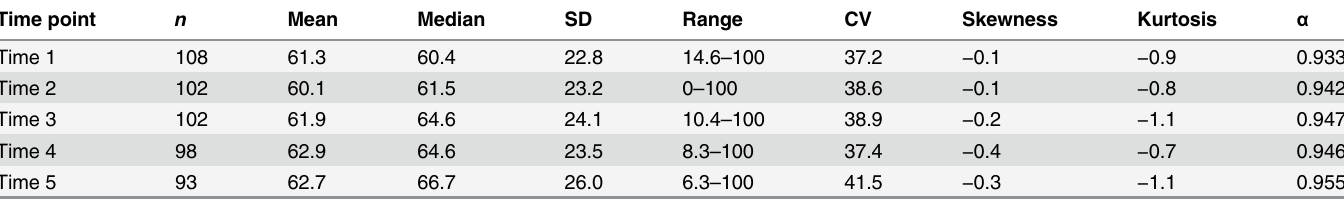
Table 2. Descriptive, distributional, and internal consistency characteristics of MSWS-12 scores for five successive time points each separated by 6 months at the group level in the sample of patients with RRMS.